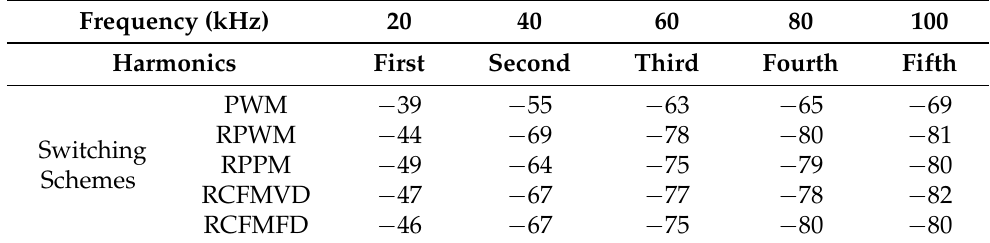
Table 2. Comparison of the current harmonics for a simple buck converter (harmonics values are in